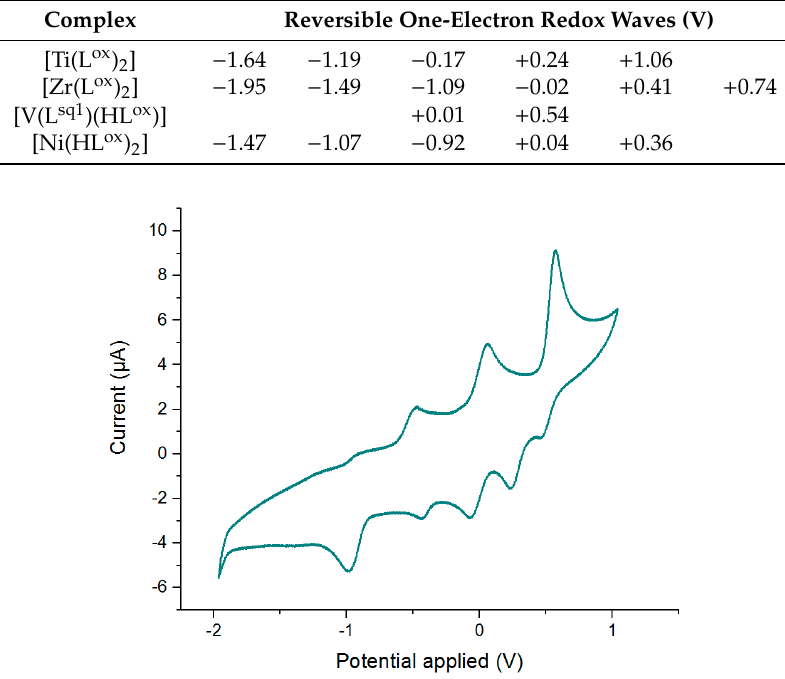
Figure 4. Cyclic voltammogram of [V(L sq1 )(HL ox )]. Cyclic voltammetry is performed at RT vs Fc / Fc + , in CH 2 Cl 2 with 100 mVs − 1 scan rate and the rotation of the measurement is clockwise.